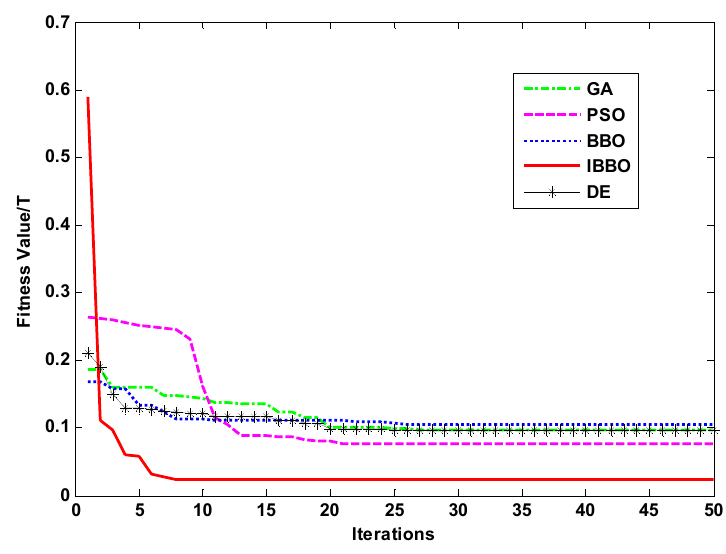
Figure 4. Optimization process of fitness function.